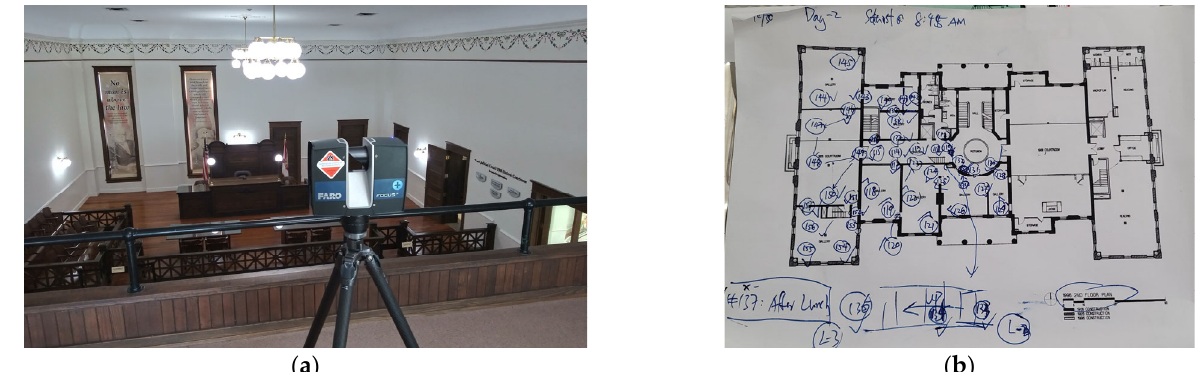
Figure 21. TLS survey of the OPCC: ( a ) laser scanning from the 3rd floor balcony of the 1908 courtroom; ( b ) field notes maintained to corroborate scan locations.